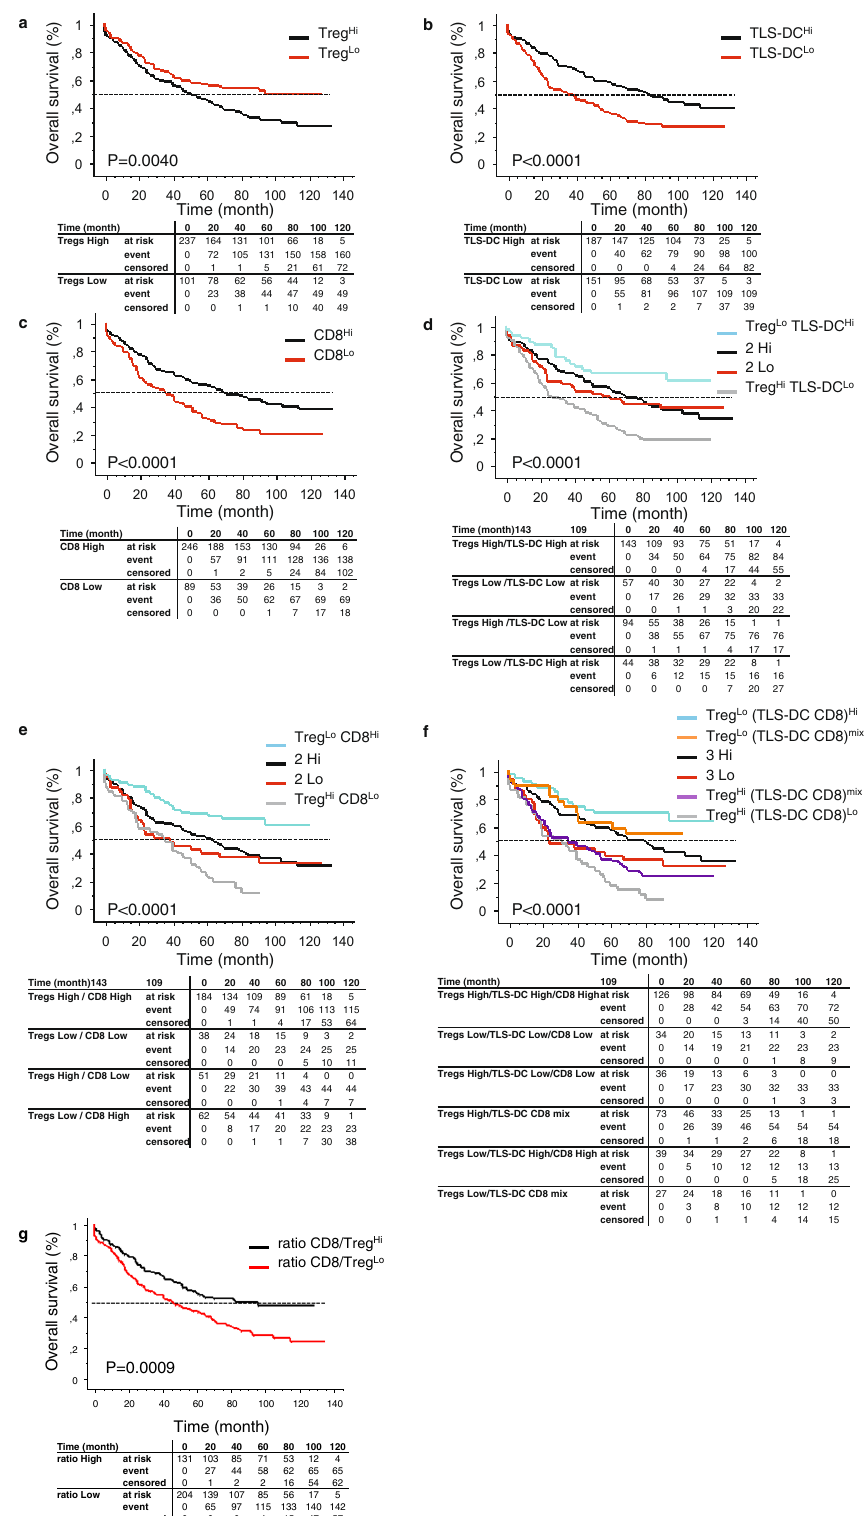
Fig. 8 Overall survival of NSCLC patients according to the densities of tumor-in fi ltrating Tregs, TLS-DC, and CD8 + T cells. Densities of total of CD3 + FoxP3 + Tregs (i.e., TIL-Tregs in fi ltrating the whole tumor section), TLS-DC-Lamp + mature DC, and CD8 + T cells were determined using serial sections of tissues ( n = 338 NSCLC). The Kaplan – Meier survival graphs were plotted for the determination of the OS of patients. The log-rank test was used to determine the statistical signi fi cance of the data. The patients were strati fi ed into high and low groups according to cell densities and survival determined ( a , Total Tregs; b , TLS-DC; c , CD8 + T cells; d , Tregs TLS-DC; e , Tregs CD8, f , Tregs (TLS-DC CD8); and g , total CD8-to-total Tregs ratio). The table below each Kaplan-Meier curve graph shows the number of patients at risk, number of events and censored according to the cell density group.